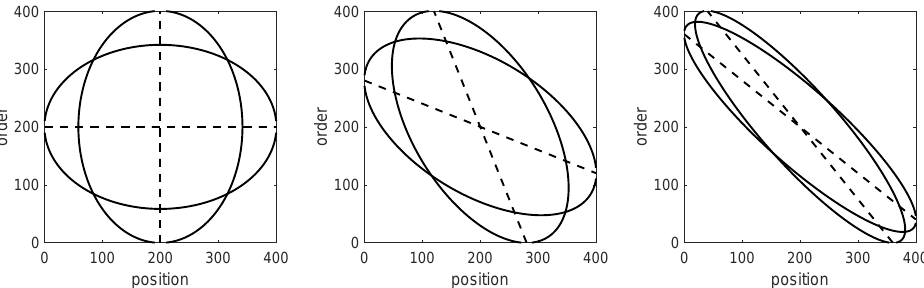
Figure 1. Examples of the energy concentrations as determined by the energy center (dashed lines) and spread (ovals) for three values of p . From left to right: p = 0.5, 0.7 and